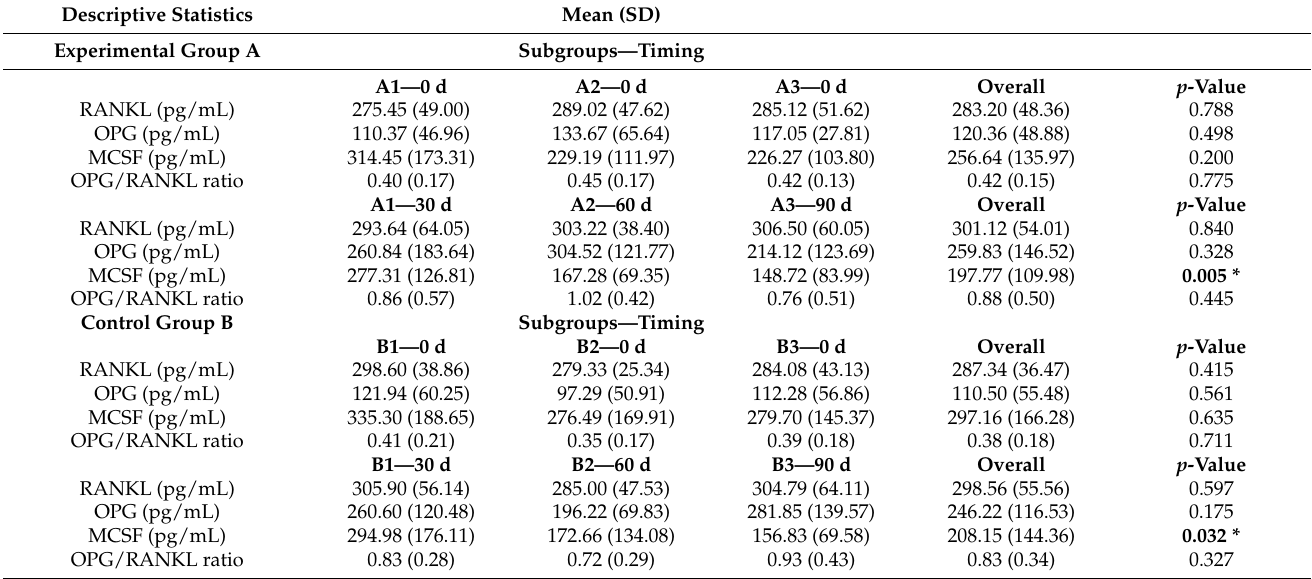
Table 1. Descriptive statistics (mean and standard deviation) for each measurement by subgroups and overall for the experimental (Group A) and control (Group B) groups.